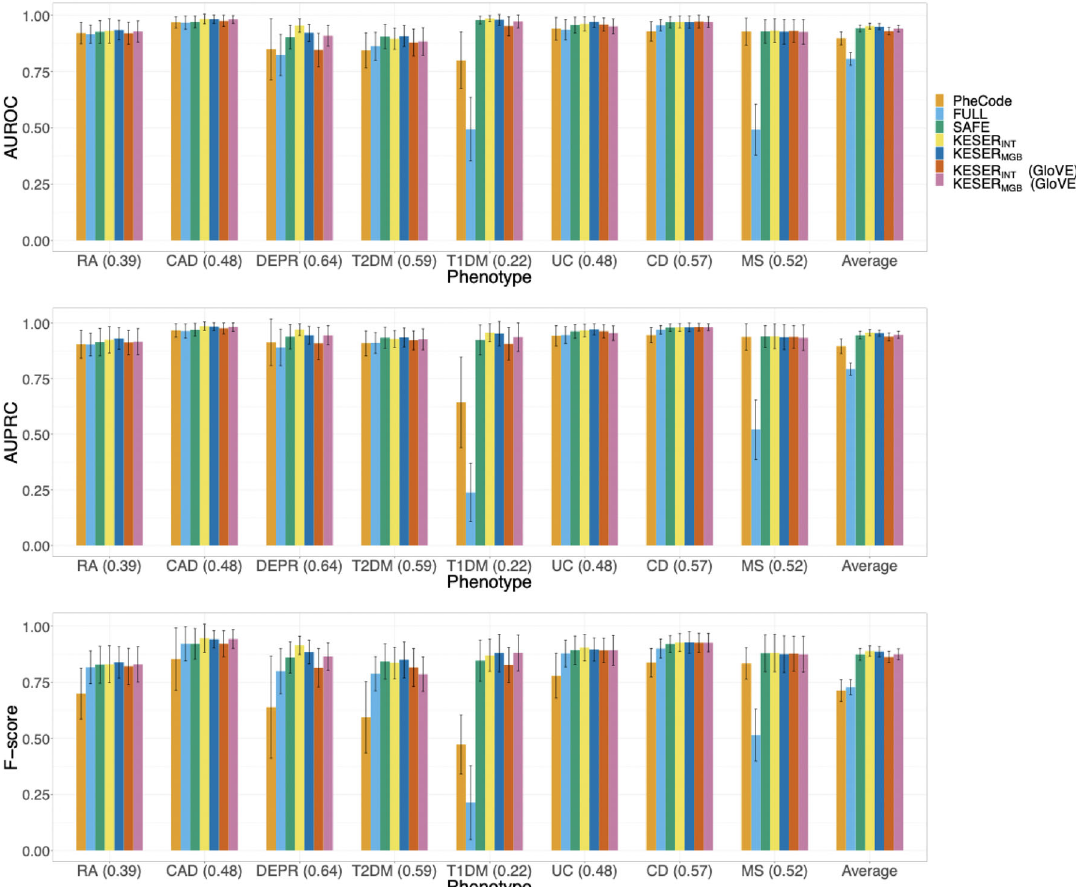
Fig. 3 Comparison of AUCROCs, AUCPRCs, and F-scores with gold standard labels for adaptive lasso phenotyping algorithms for eight diseases using the main PheCode only (PheCode), all features (FULL), SAFE selected features (SAFE), KESER MGB and KESER INT selected features based on SVD-SPPMI embeddings as well as KESER MGB and KESER INT selected features based on GloVe embeddings. F-scores are calculated at the cutoff points with the estimated prevalence equal to the population prevalence. The bootstrap based 95% con fi dence intervals (bars) are